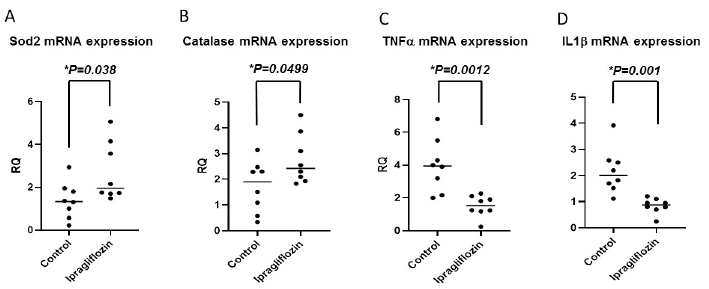
Fig 3. Ipragliflozin enhanced the antioxidative effect in the liver tissue of STAM mice. Levels of mitochondrial transport-related and antioxidant defensive system-related genes (A) Sod2 , (B) Cat , (C) TNF α , and (D) IL1 β in the ipragliflozin (n = 8) and control groups (n = 8).